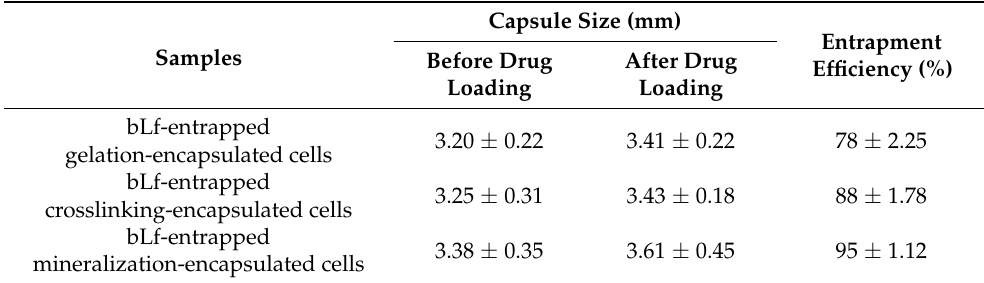
Table 1. The entrapment efficiency of bLf entrapped on the differently encapsulated L. rhamnosus GG cells. Capsule Size Samples